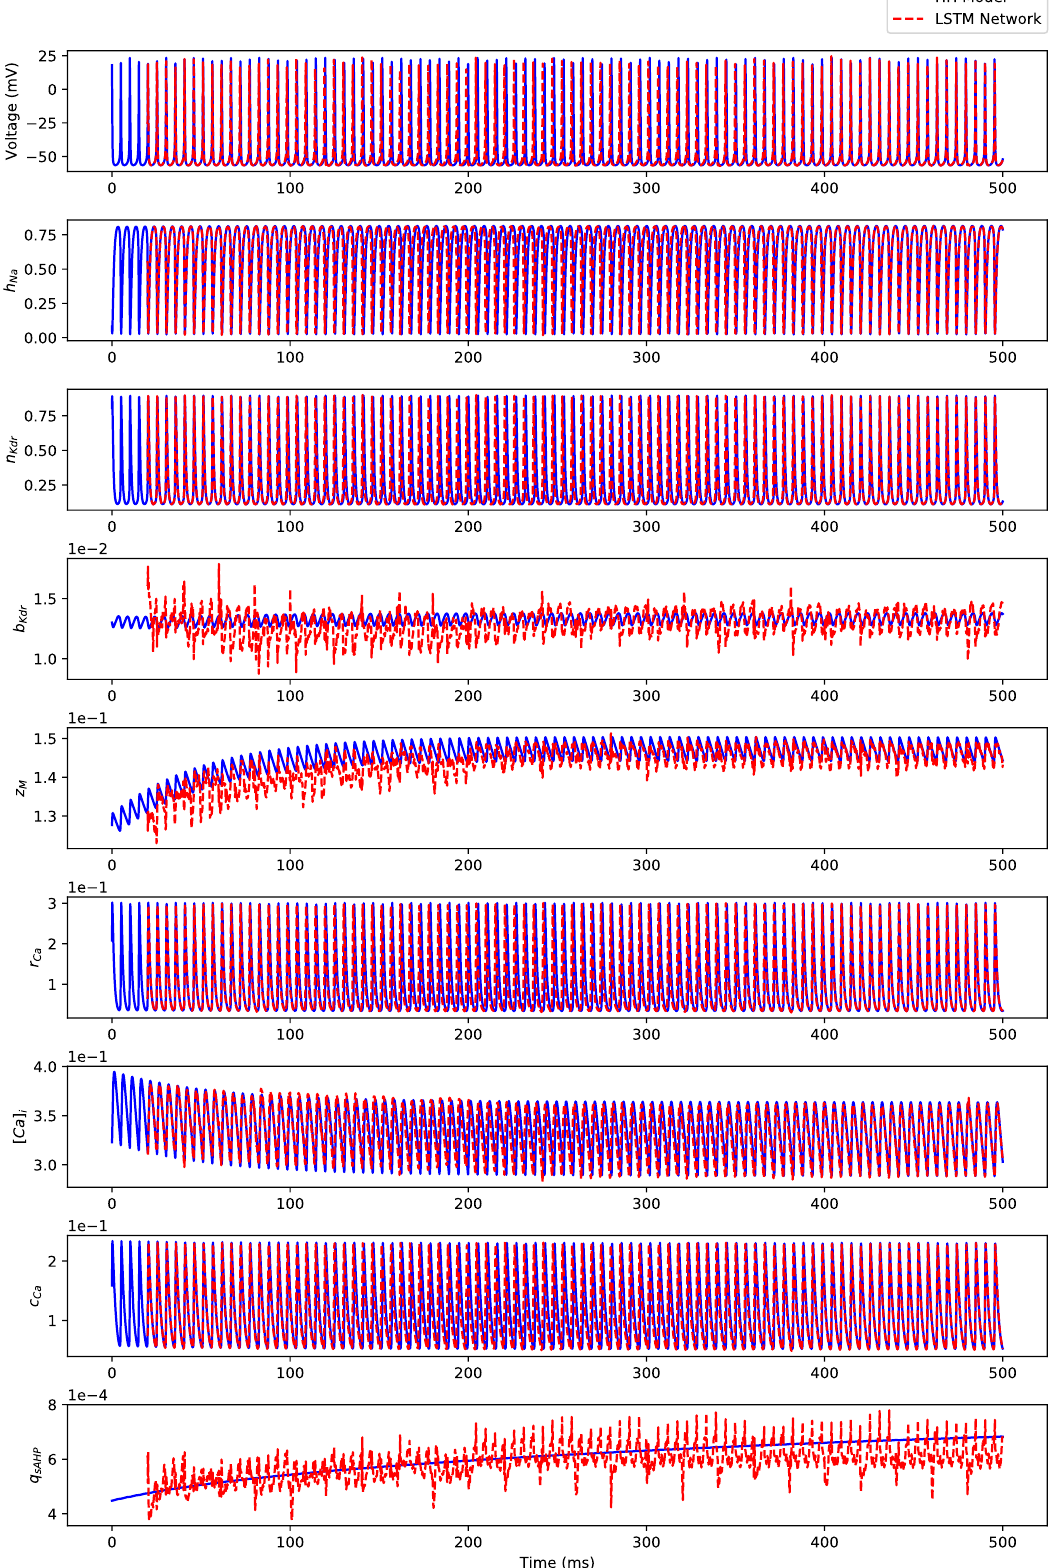
Figure A4. Comparison between the Hodgkin-Huxley model (“HH Model”) states’ dynamics and the iterative predictions of states’ dynamics using the 200 timesteps predictive horizon-based deep LSTM neural network (“LSTM Network”) in response to I = 3.0